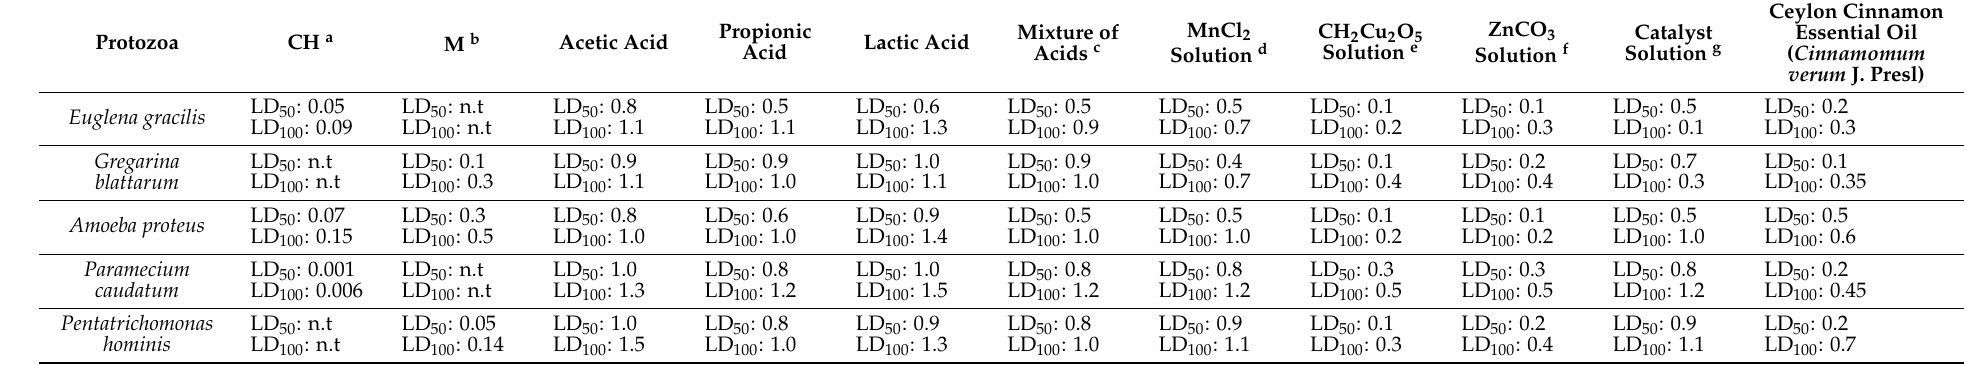
Table 6. LD 50 , LD 100 values [%] of Ceylon cinnamon essential oil ( Cinnamomum verum J. Presl) and the components used in the study.